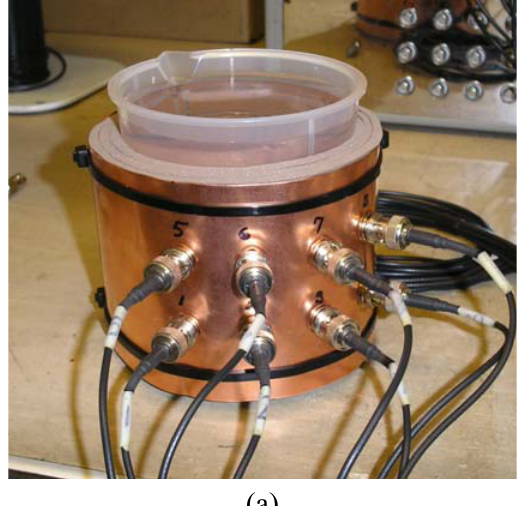
Figure 10. 8-channel on-line ECVT system: (a) photo of the 8-channel sensor; (b) on-line water surface measurement using the